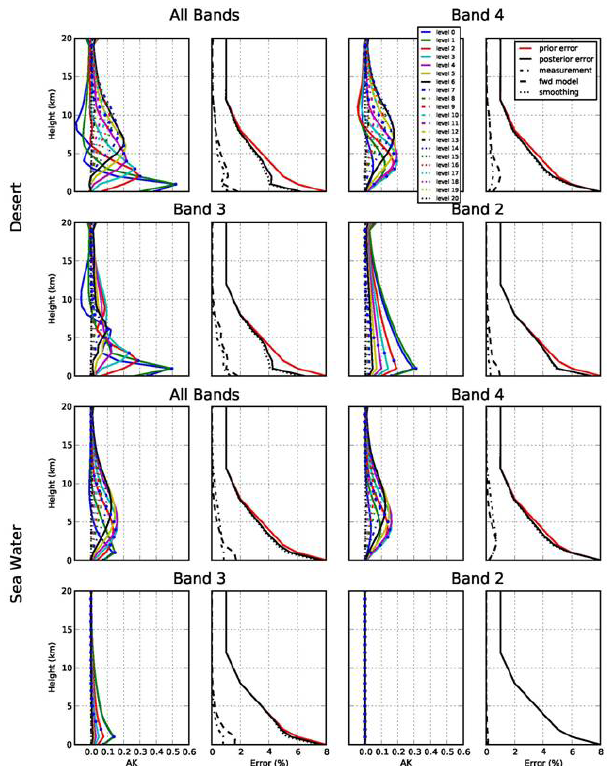
Fig. 2. Averaging kernels and error budgets of CO 2 vertical profiles for Bands 2, 3, and 4 separately and all the bands together in Case 1. the red and black lines stand for the prior ( S a ) and posterior ( S x ) errors, respectively; the smoothing ( S smoothing ) , model parameters ( S fwd.mod. ) , and measurement ( S meas. ) errors are dotted, dashed, and dashed/dotted lines, respectively. The averaging kernels of each altitude layer are represented by different colors.